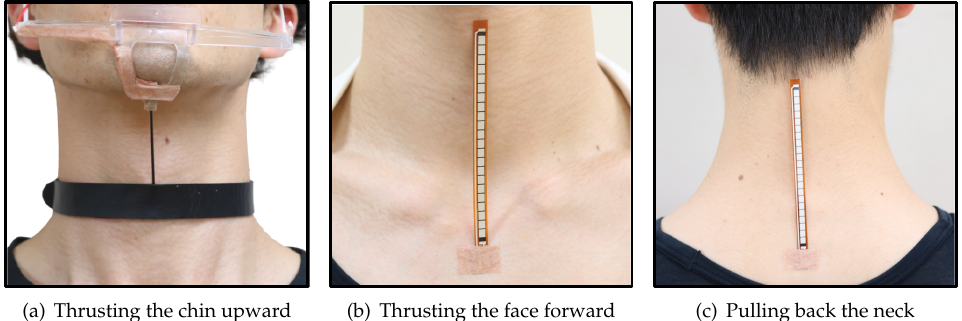
Figure 5. Sensor placements for recognizing each intuitive